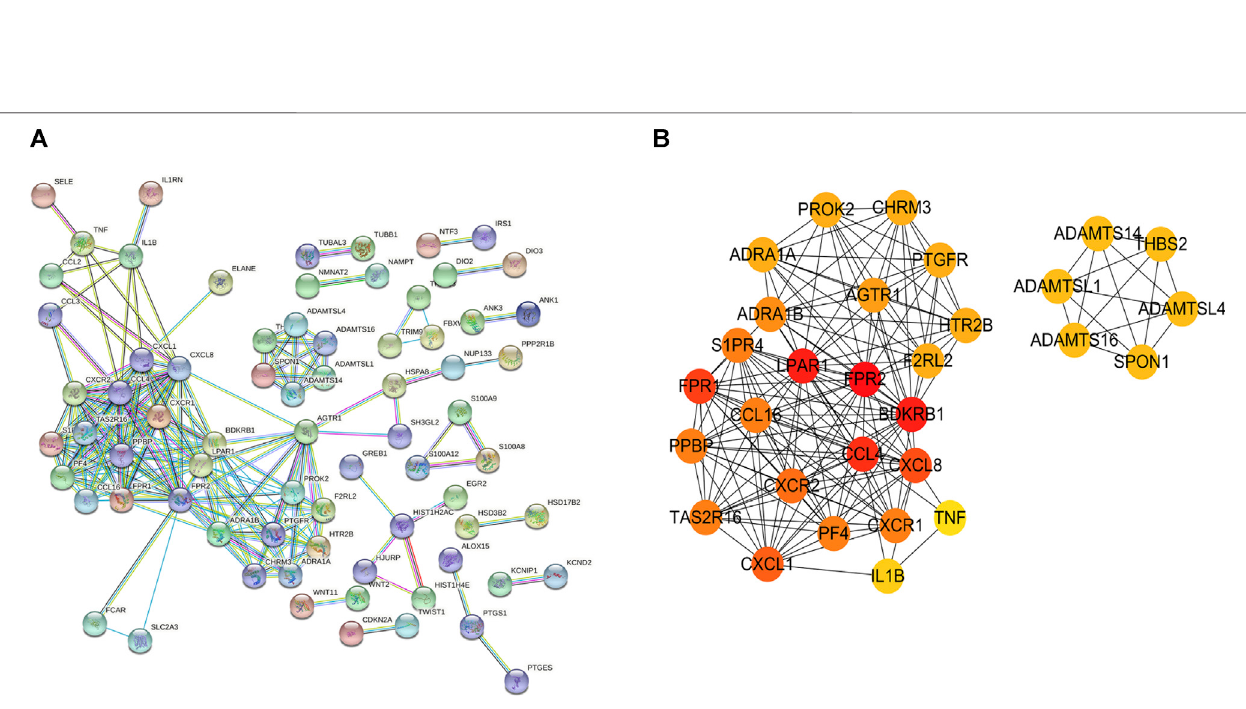
Frontiers in Genetics |